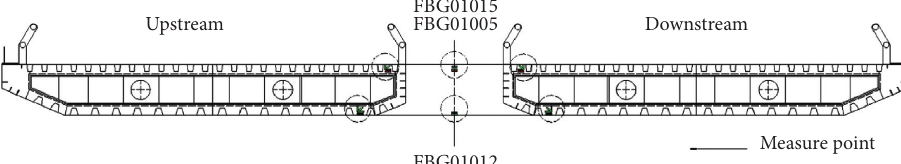
Figure 6: Sensors about section D [23, 36, 38].